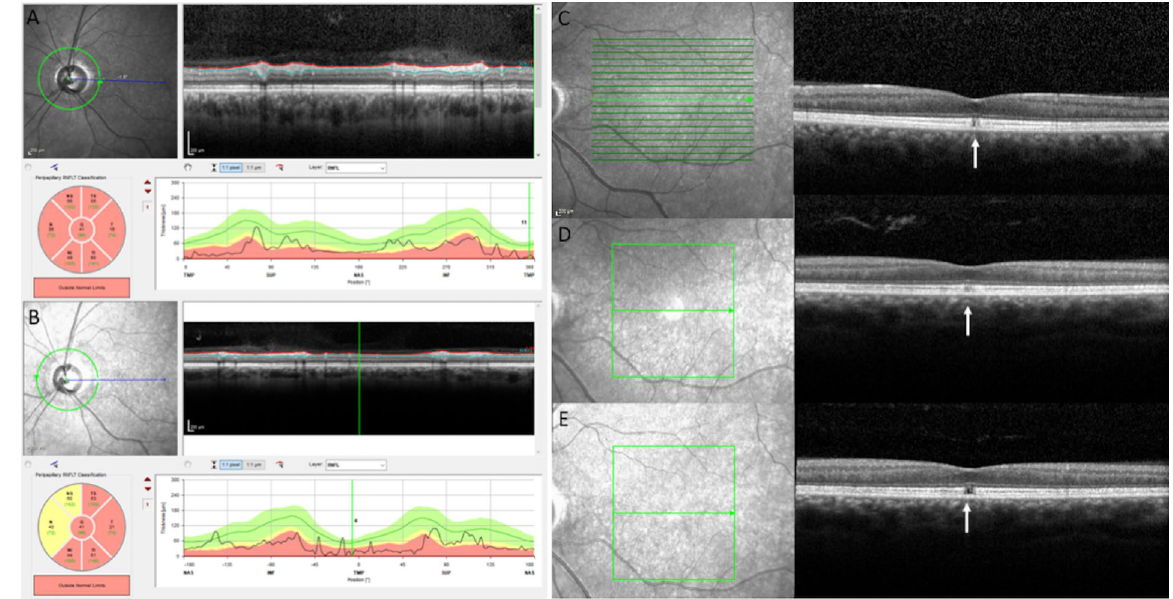
Figure 4. Stationary foveopathy in the individual V-11 with a 7 year SD-OCT follow-up. Visual acuity was severely decreased in both eyes, 20/400 at the age of 46 years and 20/800 at the age of 53 years. ( A , B ) RNFL thickness at initial (46 years) and final examinations (53 years) were severely reduced. ( C – E ) Infrared reflectance photographs and transfoveal scans of the patient at the age of 46 years ( C ), 50 ( D ) and 53 years ( E ) of the left eye. The foveal defect of the EZ and IZ lines was very small without any enlargement over time (white arrows). Photographs were taken by IM. SD-OCT parameters No foveopathy Plus